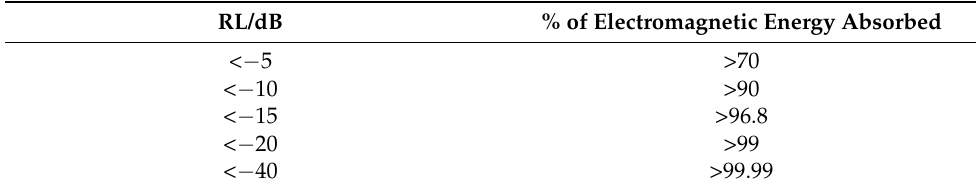
Table 2. Relation between RL and percentage